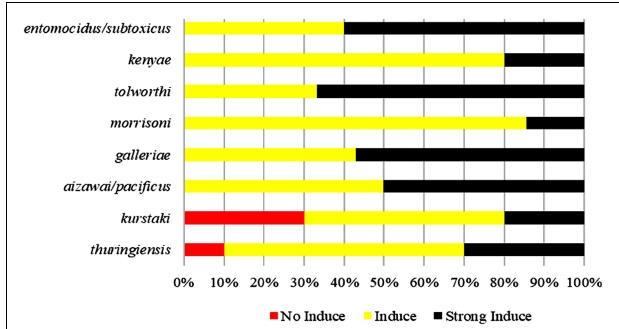
FIGURE 2 | Comparison of induction ability of pectin on the biofilms formed by different Bt